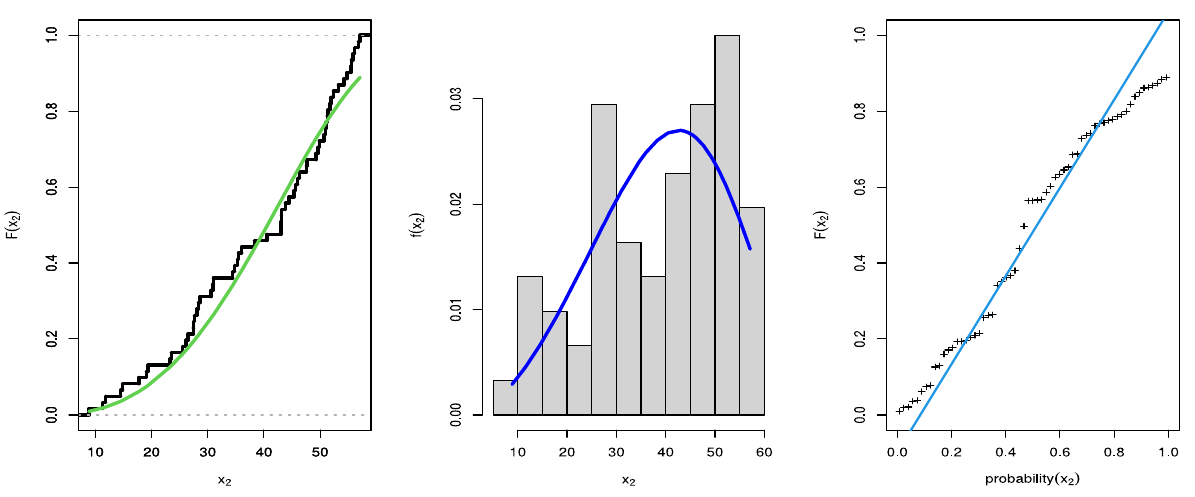
Figure 1. Fitted CDF with empirical CDF, estimated PDF, and P-P plots for first stress levels.